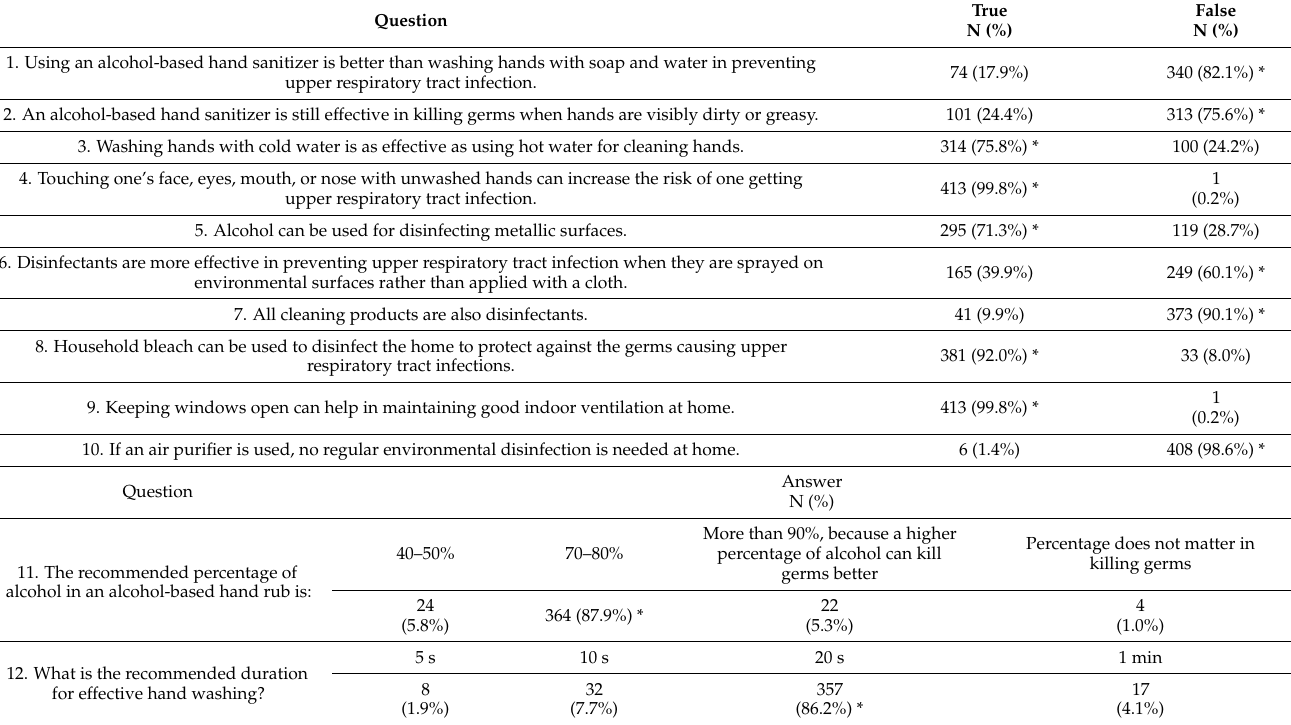
Table 2. Parental knowledge of the importance of personal and home hygiene in preventing URTIs in